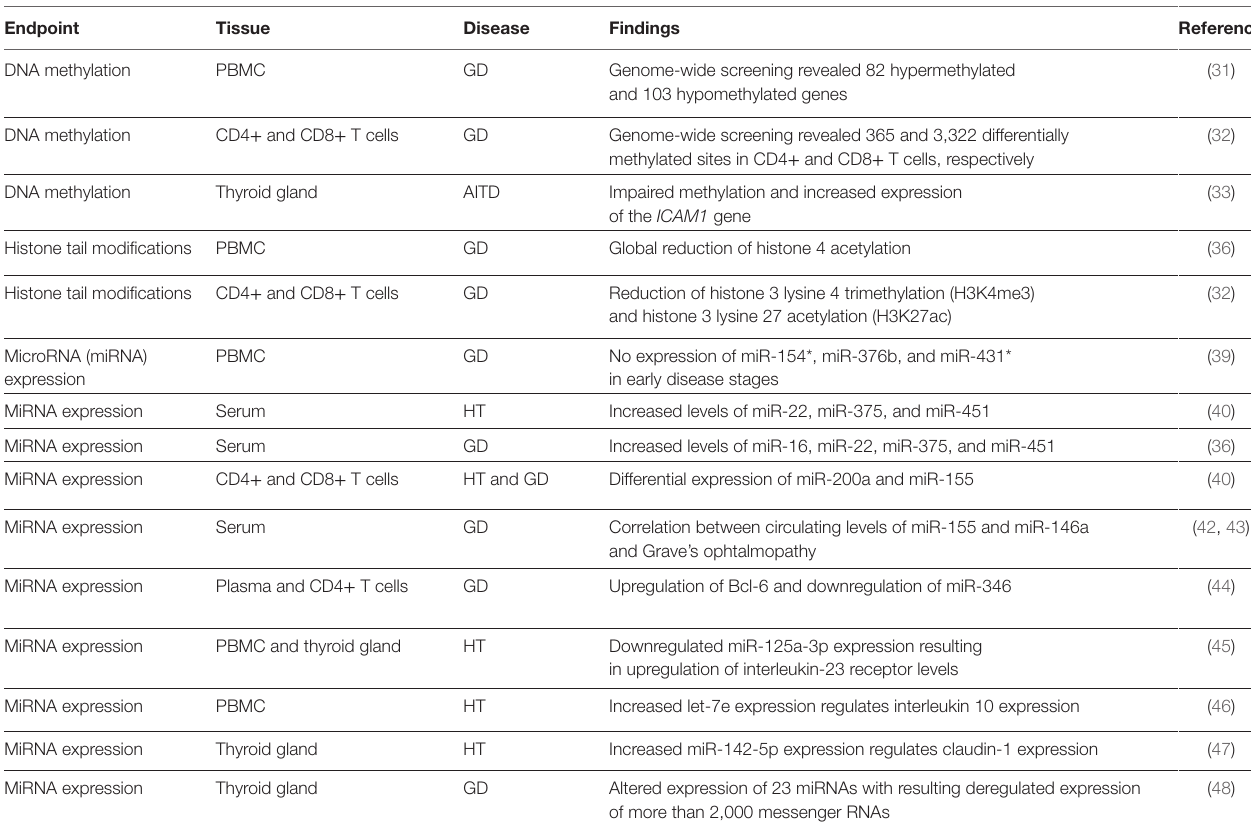
TAbLe 1 | Epigenetic studies in patients with